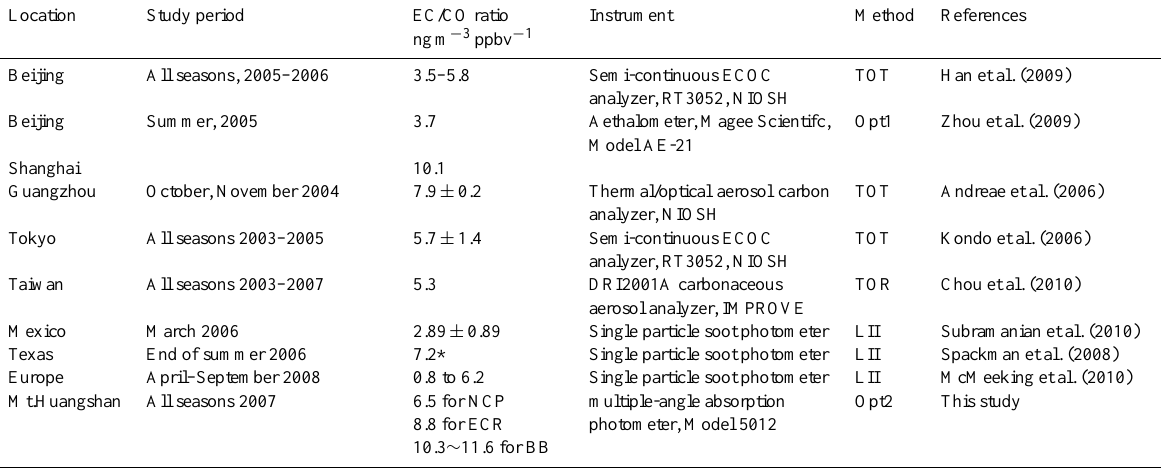
Table 4. Comparisons with results of other observation studies.